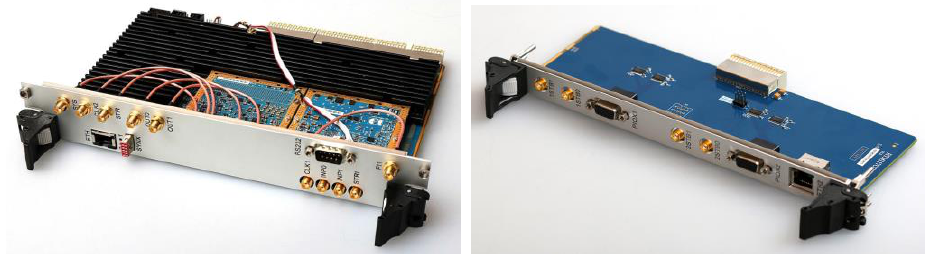
Fig. 6. Appearance of modernized DSP module (left) and new rear module (right) realized for new